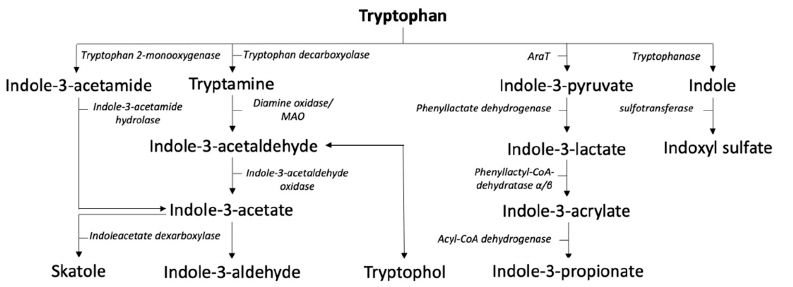
Figure 3. Indole pathway. Abbreviations: AraT; aromatic amino acid aminotransferase, MAO; monoamino oxidase.